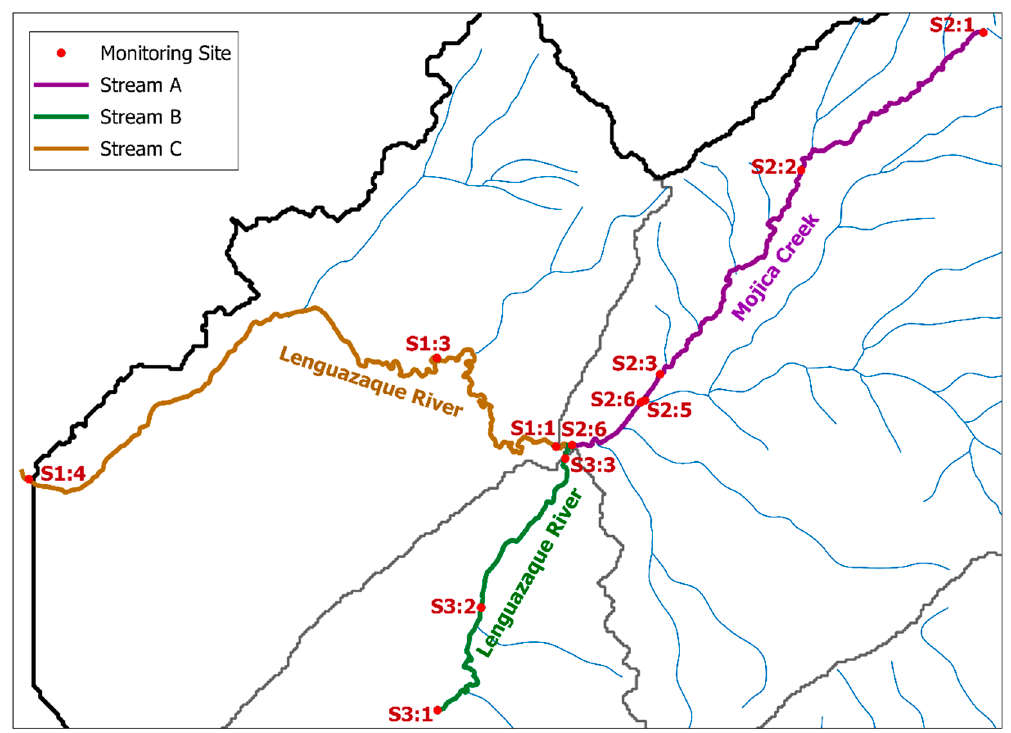
Figure 7. Modeled streams and monitoring sites.